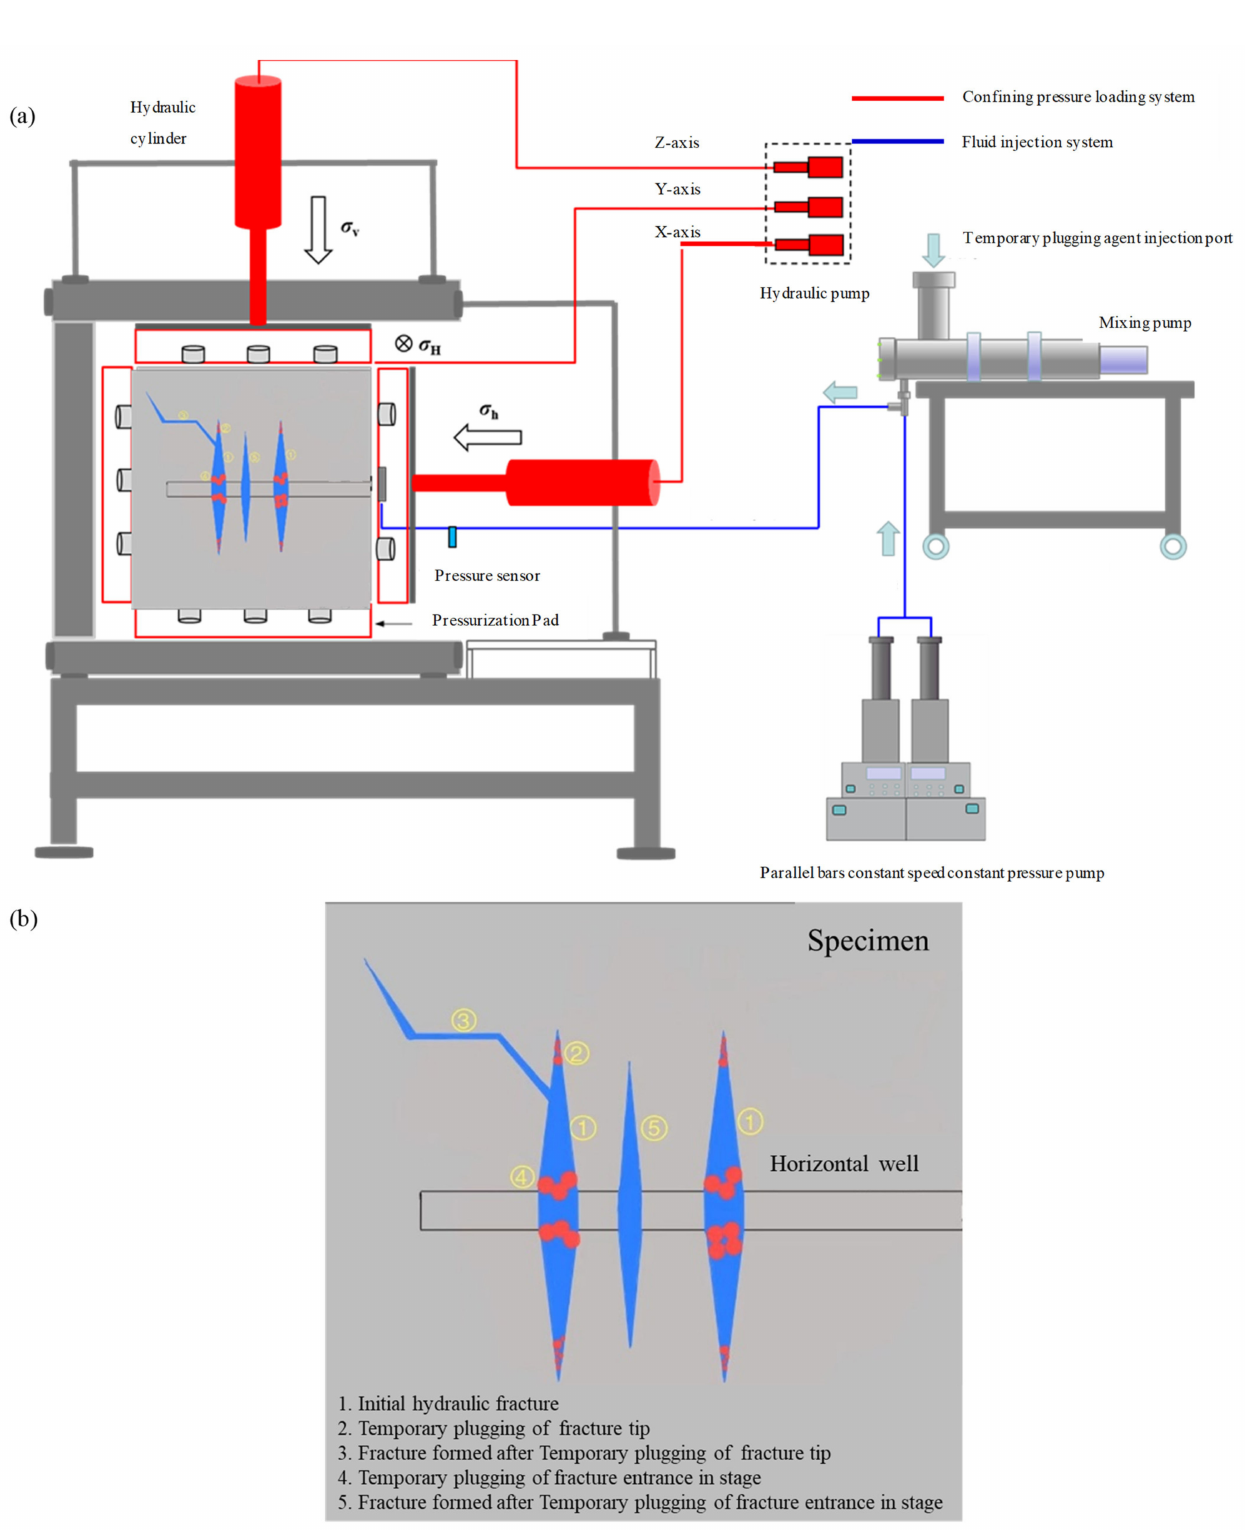
Figure 2. ( a ) Schematic diagram of horizontal well temporary plugging fracturing experimental device; ( b ) Schematic diagram of sample temporary plugging crack